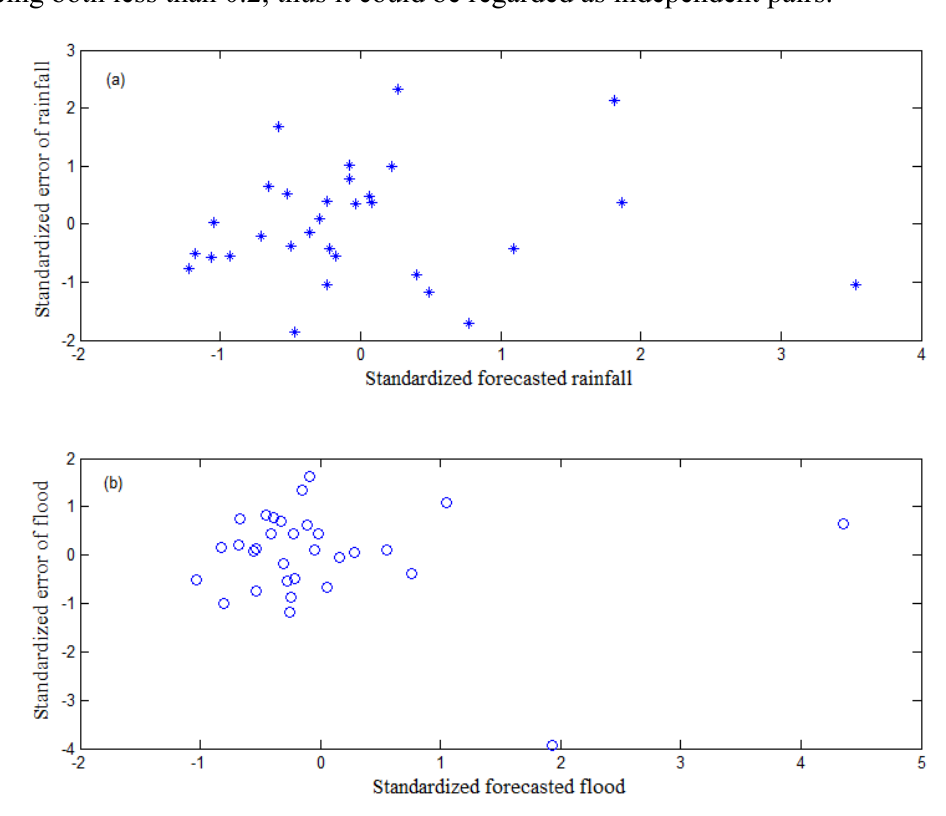
Figure 4. Relationship of ( a ) standardized forecasted rainfall and standardized error of rainfall; and ( b ) standardized forecasted flood and standardized error of